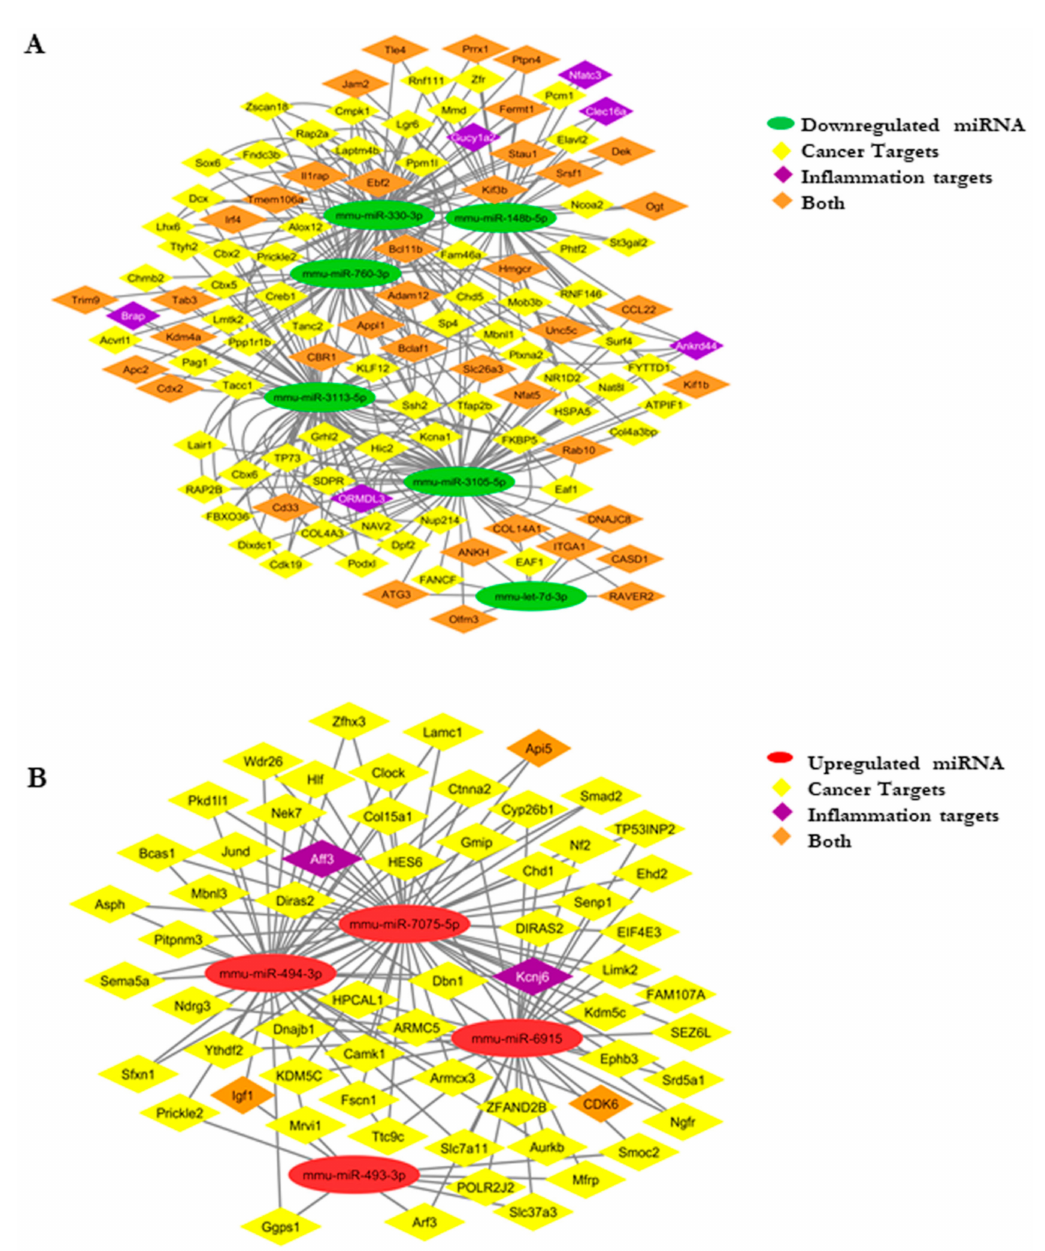
Figure 6. ( A ) miRNA–mRNA network: downregulated miRNA–gene network showing the targets specific for cancer, inflammation, and together. ( B ) The upregulated miRNA–mRNA network representing the targets specific for cancer, inflammation, and